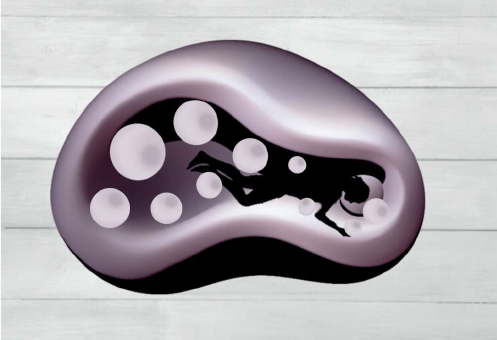
Figure 1. Design concept for the installation.